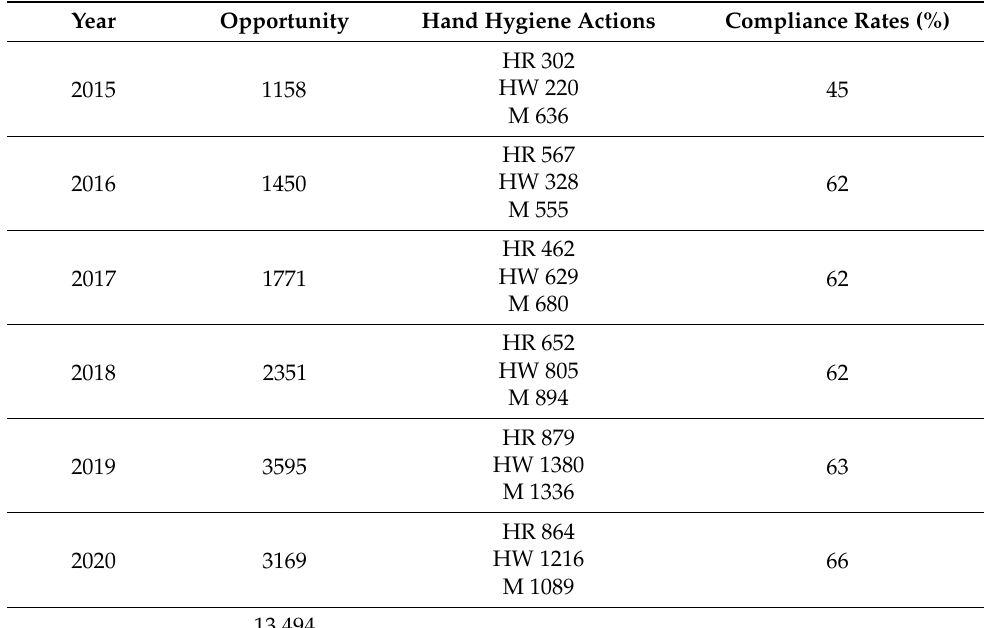
Table 1. Overall hospital hand hygiene compliance procedures per